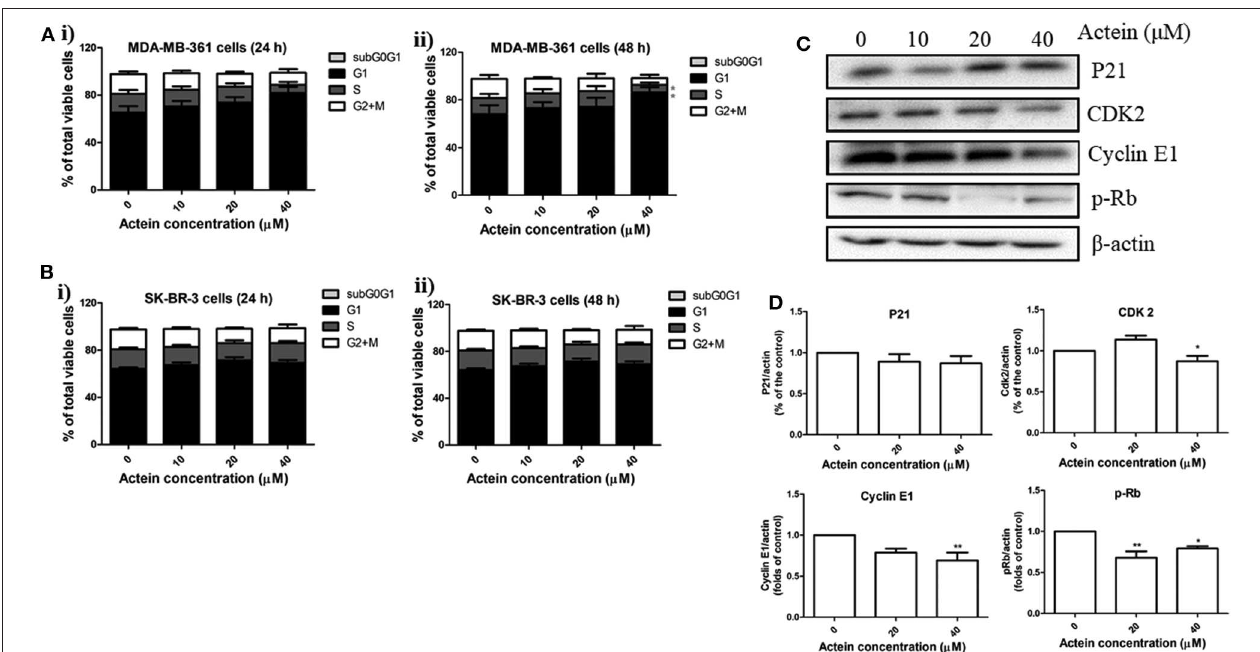
FIGURE 3 | Actein mediated MDA-MB-361 cell arrest in G1 phase through the modulation of p21-cyclin E1/CDK2-pRb pathway. Cell cycle of (A) MDA-MB-361 cells and (B) SK-BR-3 cells treated with actein for (i) 24 and (ii) 48h were evaluated by flow cytometry, results were presented as mean + SD of four independent experiments in bar charts. (C) Western blot analysis of p21-cyclin E1/CDK2-pRb pathway related proteins in MDA-MB-361 cells upon 48h treatment with actein (10–40 µ M). (D) Bar charts show the expression levels of proteins of P21, CDK2, Cyclin E1, and pRb, which were adjusted with corresponding β -actin protein level and expressed as fold of control (mean fold of control + SD from four independent experiments). Differences among the treated and vehicle treated control groups were determined by One-way ANOVA. * p < 0.05 and ** p < 0.01 as compared to control